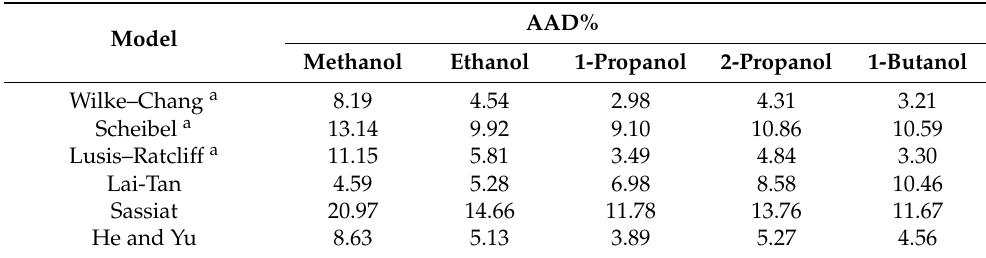
Table 2. The average absolute deviation ( AAD% ) for the predictive equations in the estimation of the diffusion coefficients for short chain alcohols in supercritical CO 2 at pressure p =10.5 MPa and at different temperatures from 306.15 to 331.15